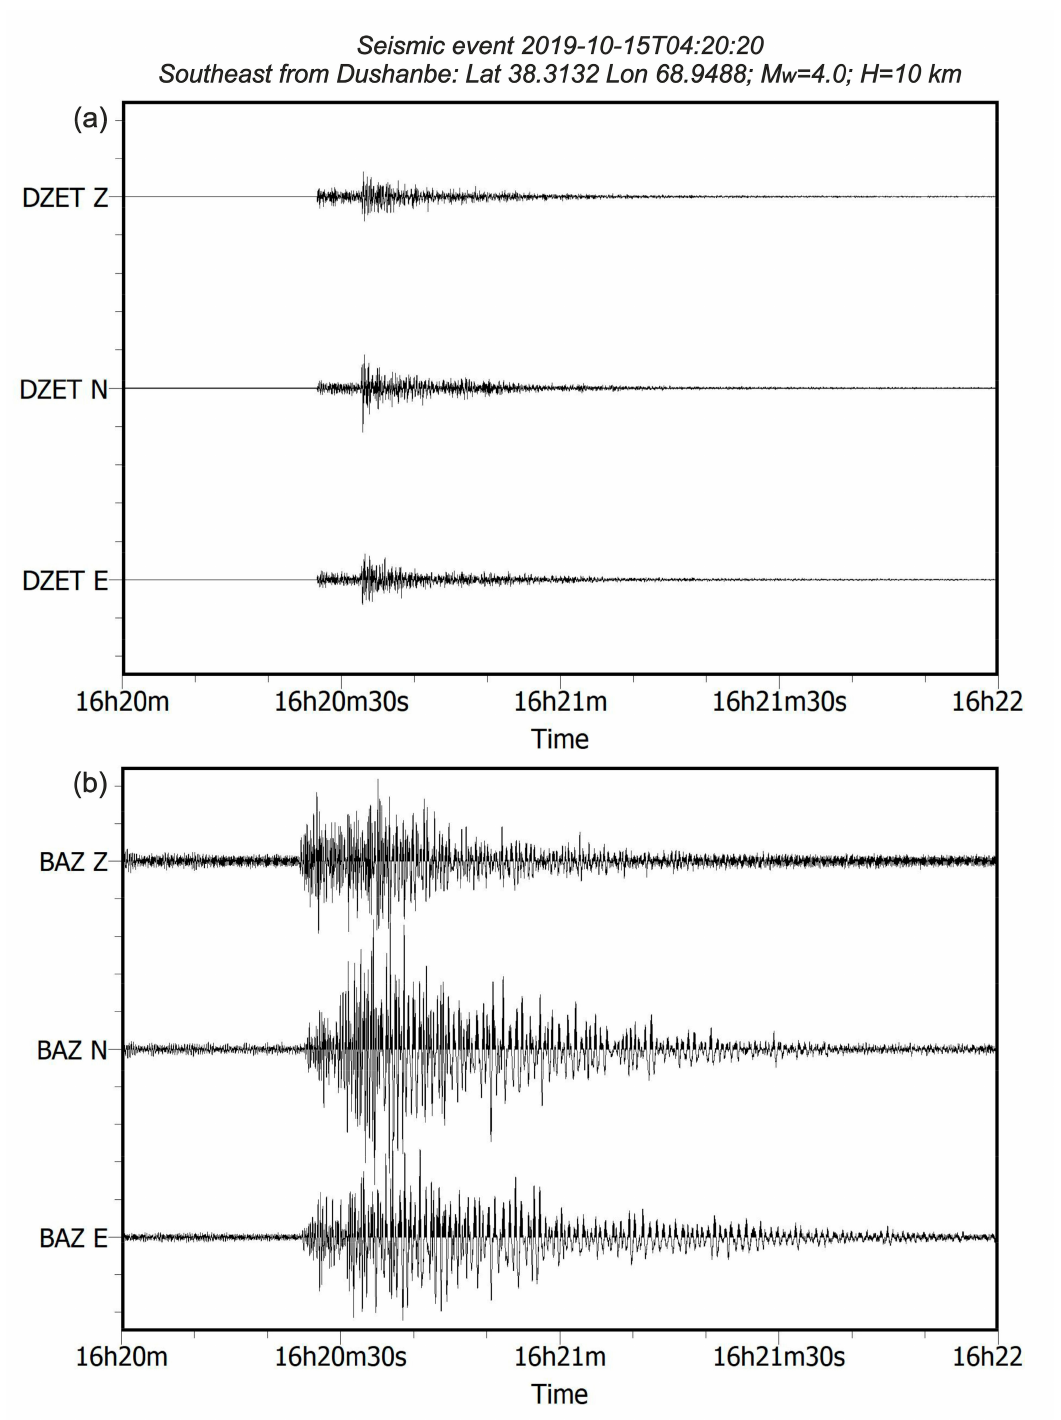
Figure 10. Examples of triaxial seismograms (E for E-W, N for N-S, and Z for vertical) for one of the five events recorded at reference station DZET ( a ); on rock and BAZ ( b ); on loess. The epicenter of the 4.0 event is 30 km southeast from Dushanbe. Amplitude scales are the same for all